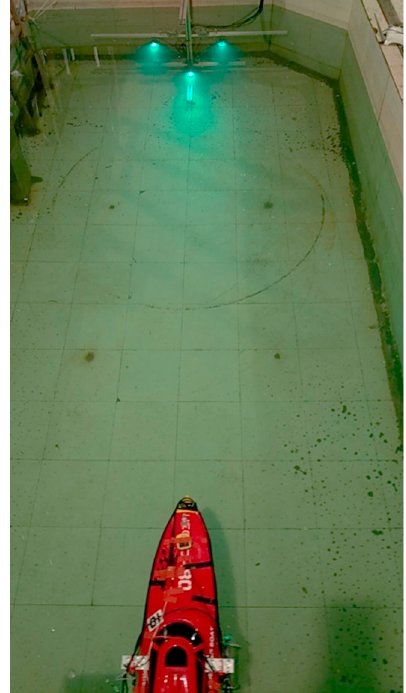
Figure 15. The ship model used in this experiment.